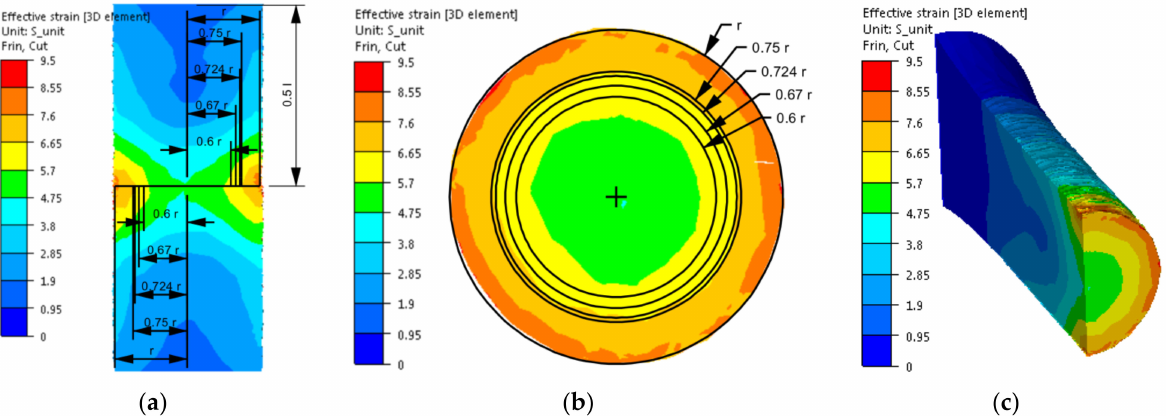
Figure 7. Distribution of the strain intensity of the 5019 aluminium alloy calculated numerically using coefficients from Table 1: ( a ) longitudinal section, ( b ) cross-section—centre of the working part and ( c )